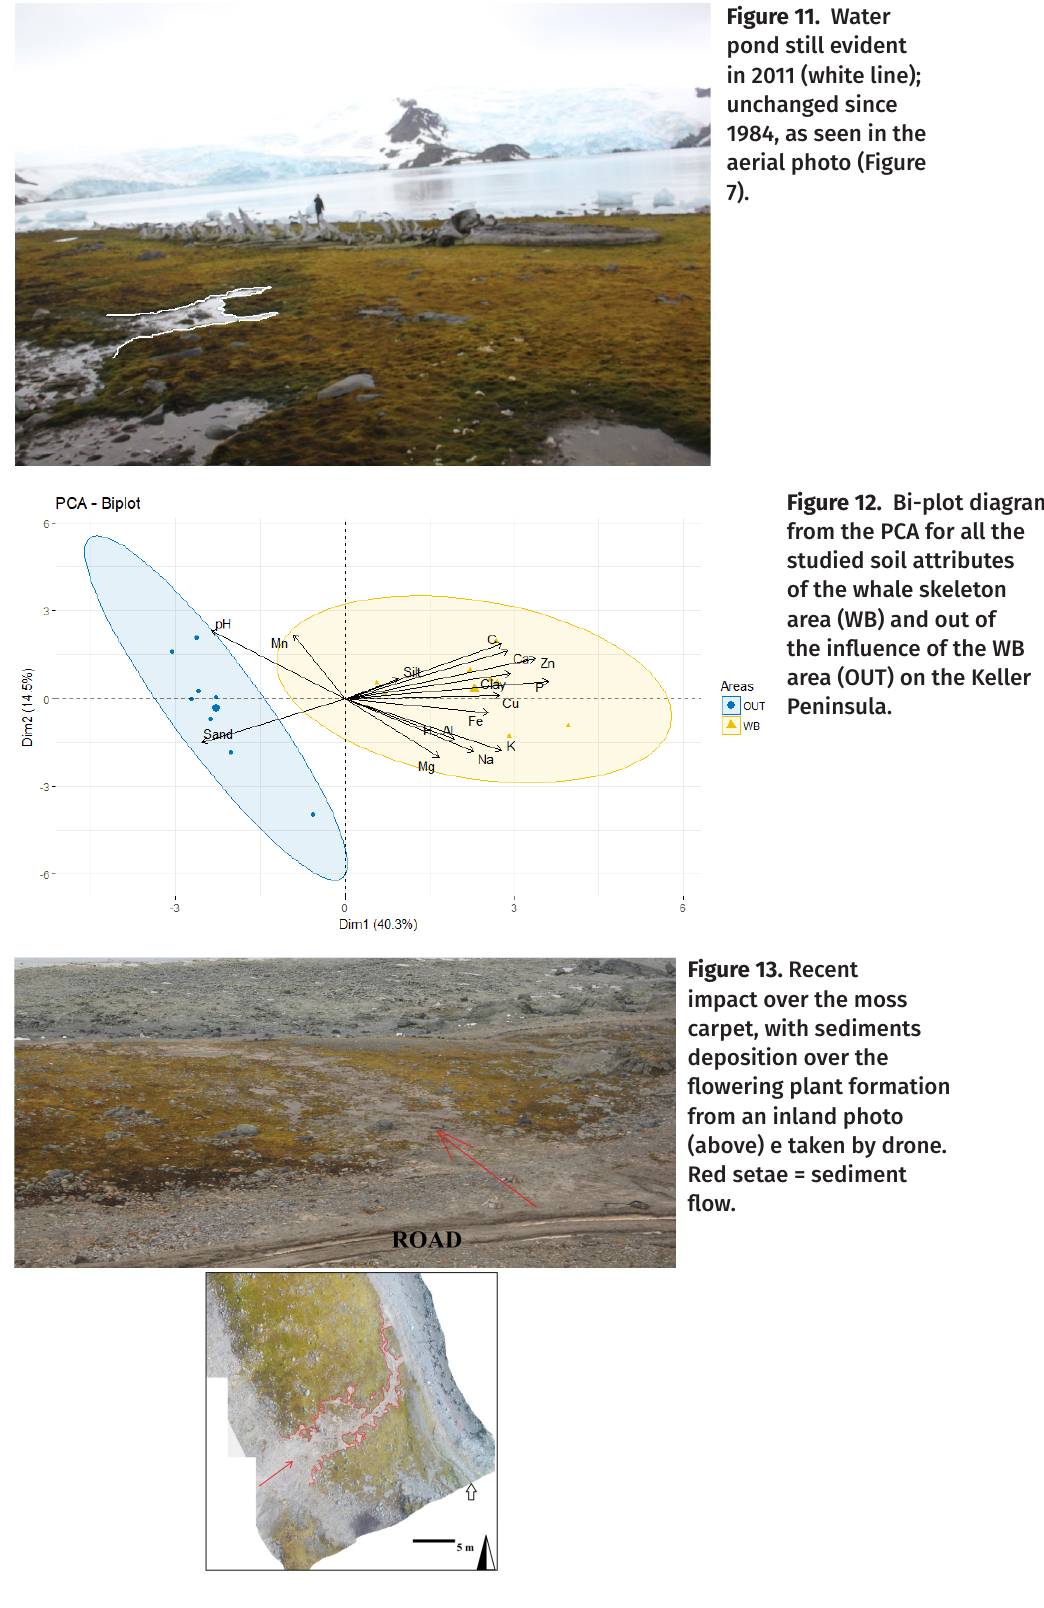
Figure 11. Water pond still evident in 2011 (white line); unchanged since 1984, as seen in the aerial photo (Figure 7).